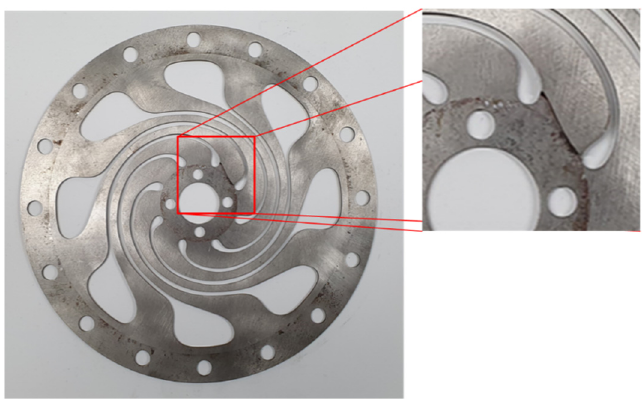
Figure 21. Broken spring through fatigue test under the displacement amplitude of 12 mm.